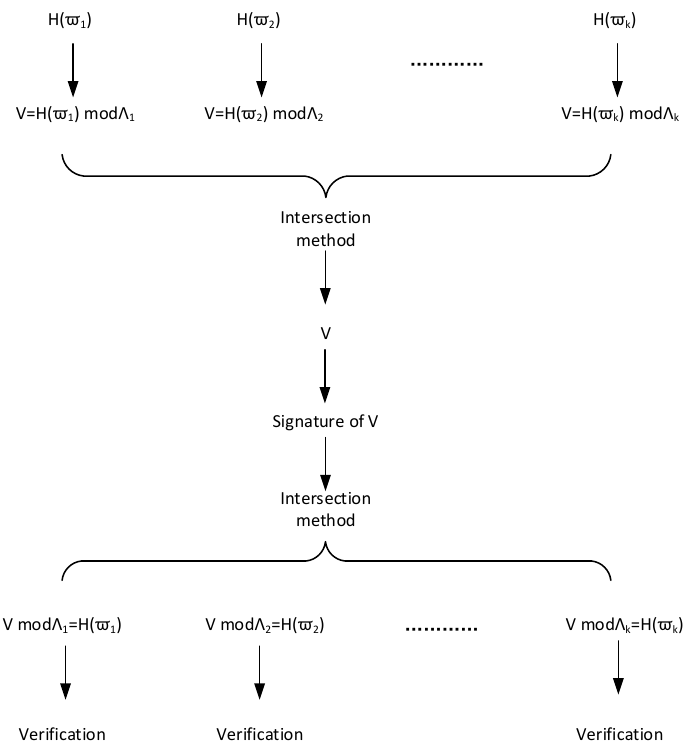
Figure 2. The Schematic of the Intersection